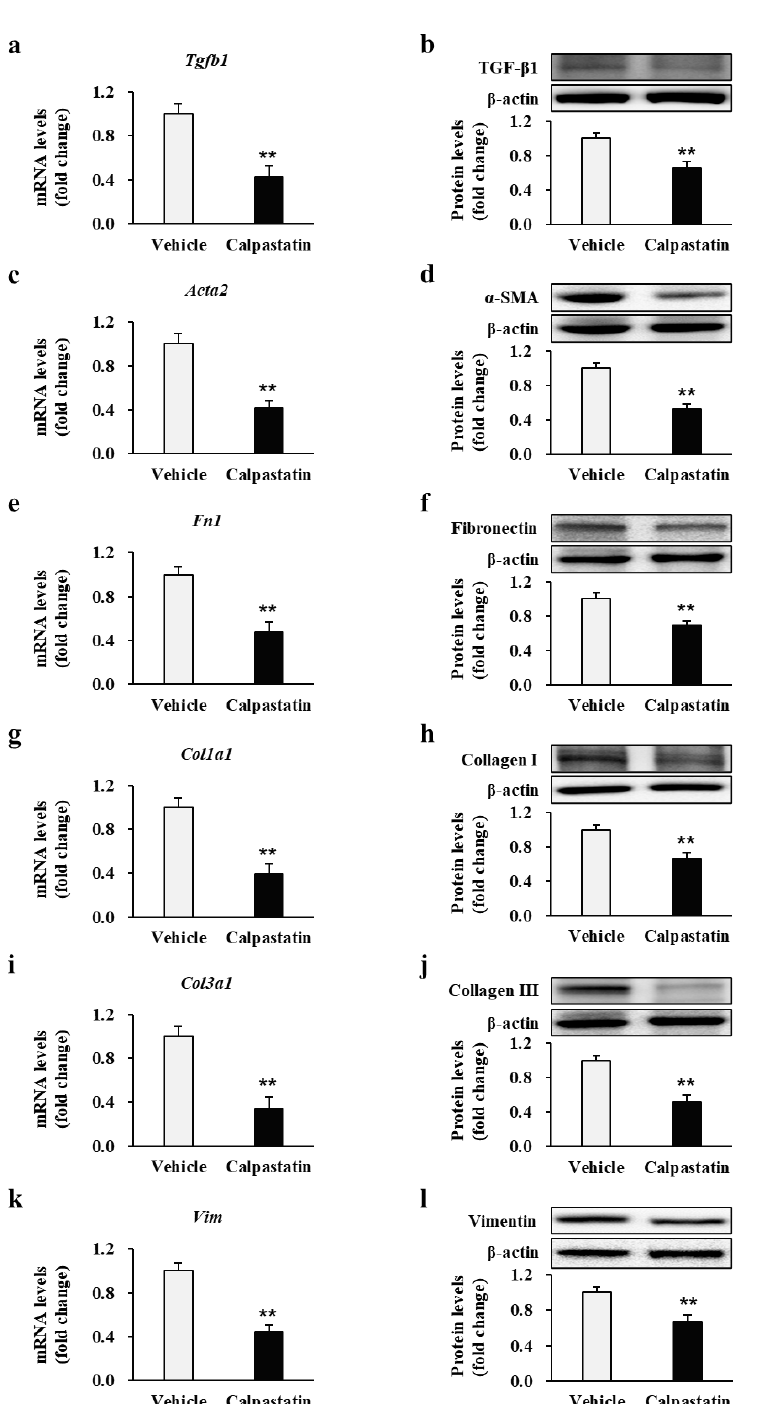
Figure 6. Effect of calpastatin on fibrotic marker expression in burn wounds of mice. The mRNA and protein levels of ( a , b ) TGF- β 1, ( c , d ) α -SMA, ( e , f ) fibronectin, ( g , h ) collagen I, ( i , j ) collagen III, and ( k , l ) vimentin in burn-wound tissues of mice administrated calpastatin once daily for 28 d post-burn injury were compared with those in vehicle-treated mice. All expression levels were normalized to those in vehicle-treated mice, in which the mean value for vehicle controls was designated as value 1. ** p < 0.01. Data represent mean ± standard error of the mean; n = 36 (vehicle) and n = 36